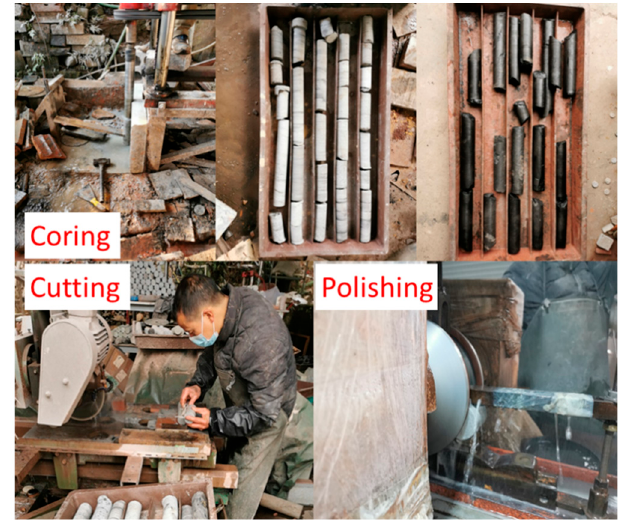
Figure 4. Processing of standard specimens.